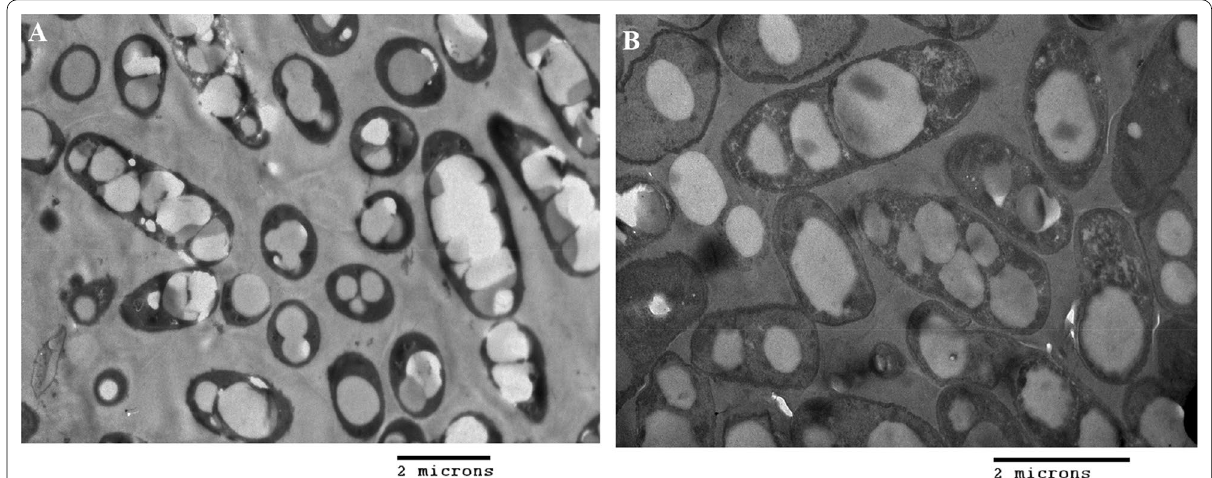
Fig. 3 TEM micrographs of PHA granules accumulated by strain VK98 on: A glucose‑based culture medium and B rice straw hydrolysate‑containing medium, respectively